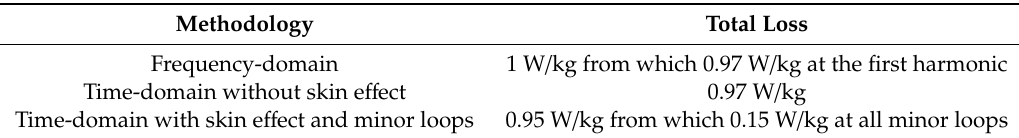
Figure 8. ( a ) Measured hysteresis loop for a 50 Hz, 0.9 T sinusoidal polarisation that was generated via a PWM scheme and ( b ) corresponding measured polarisation waveform. The minor loops that were separately calculated are marked in red. Table 1. Comparison of loss predictions for the data shown in Figure 8, for which a total loss of 0.967 W / kg was